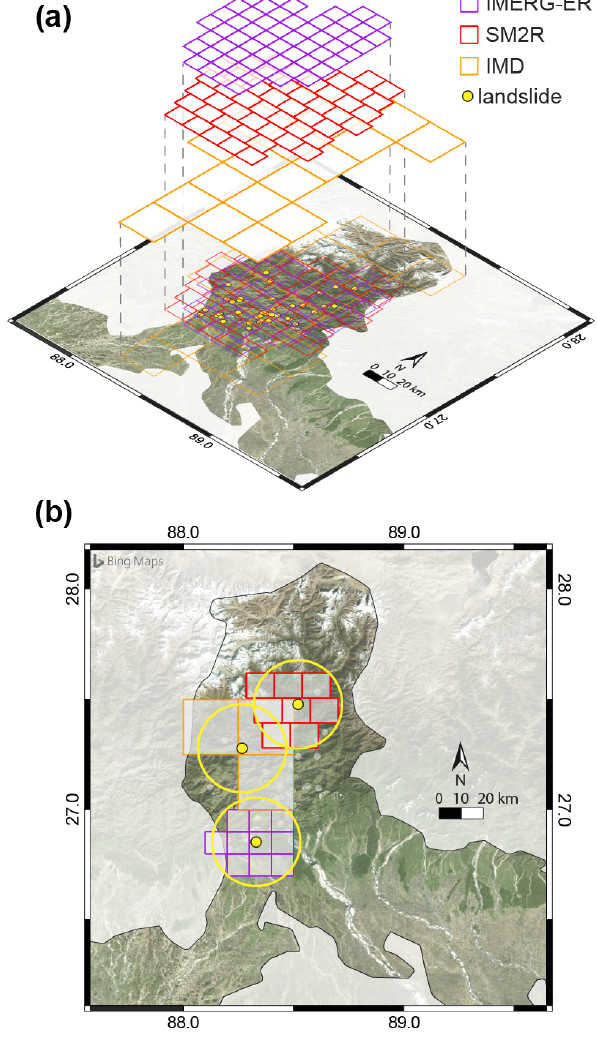
Figure 5. (a) Comparison of the pixel resolution for the satellite- based IMERG, SM2RAIN and the ground-based IMD rainfall prod- ucts. (b) Example of the pixel selection for three landslides using a 20km buffer (yellow circle) for the state of Assam. Background im- age from Bing ©